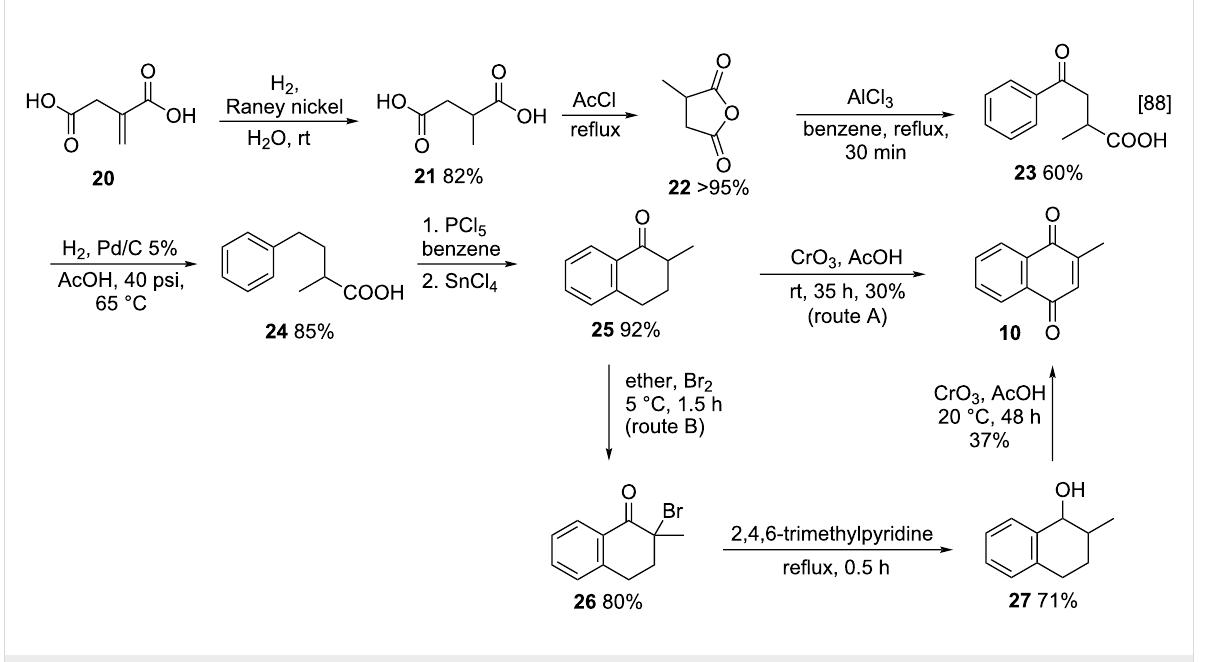
Scheme 4: Synthesis of menadione ( 10 ) from itaconic acid.